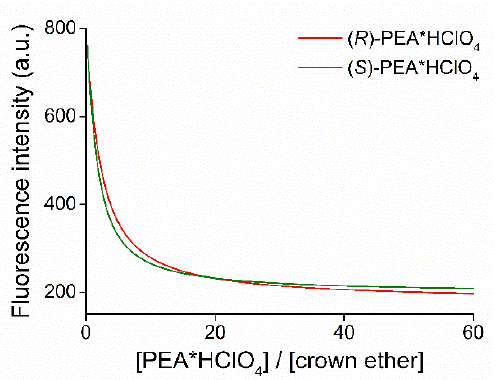
Figure 9. Fitted nonlinear functions for the determination of complex stability constants.